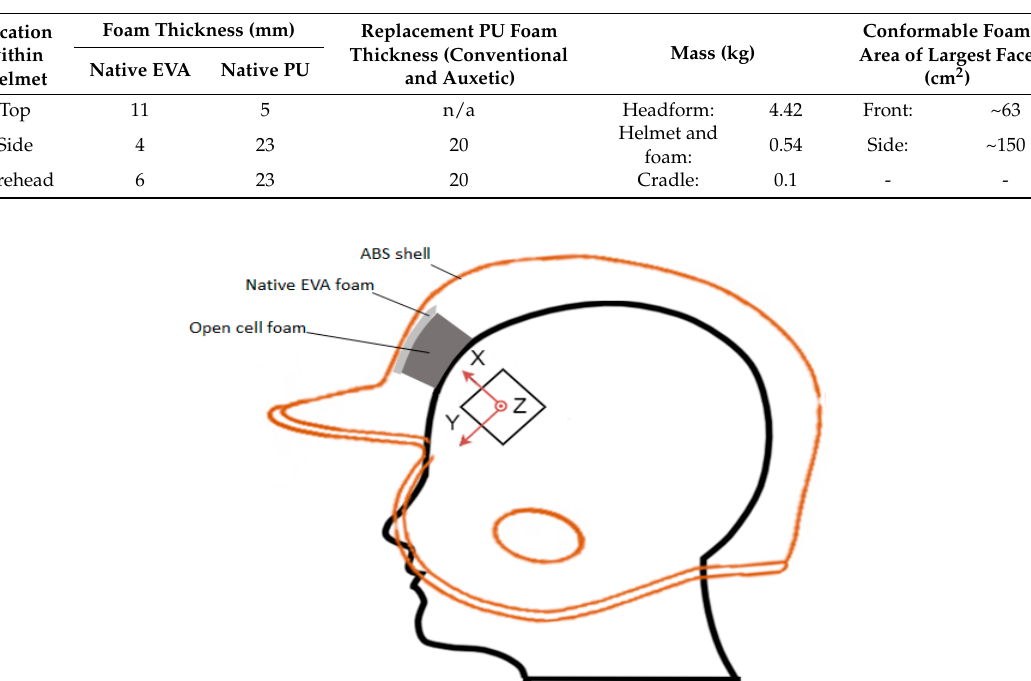
Figure 3. Schematic of the experimental setup depicting cradle to suspend the headform for frontal impact ( left ) and side impact ( right ).